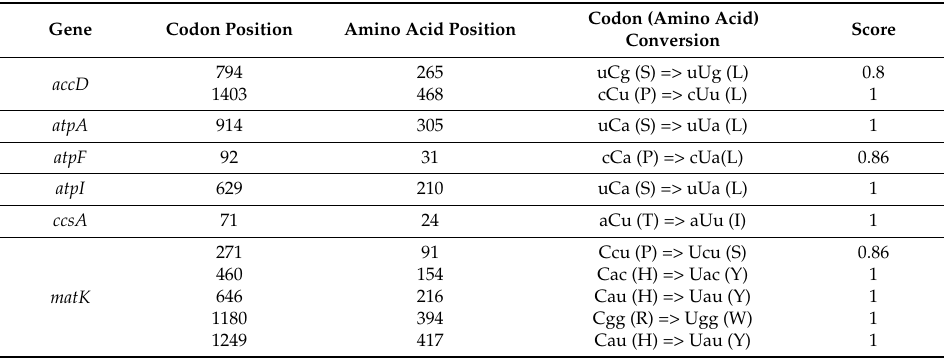
Table 6. The predicted RNA editing site in the Forsythia suspensa chloroplast